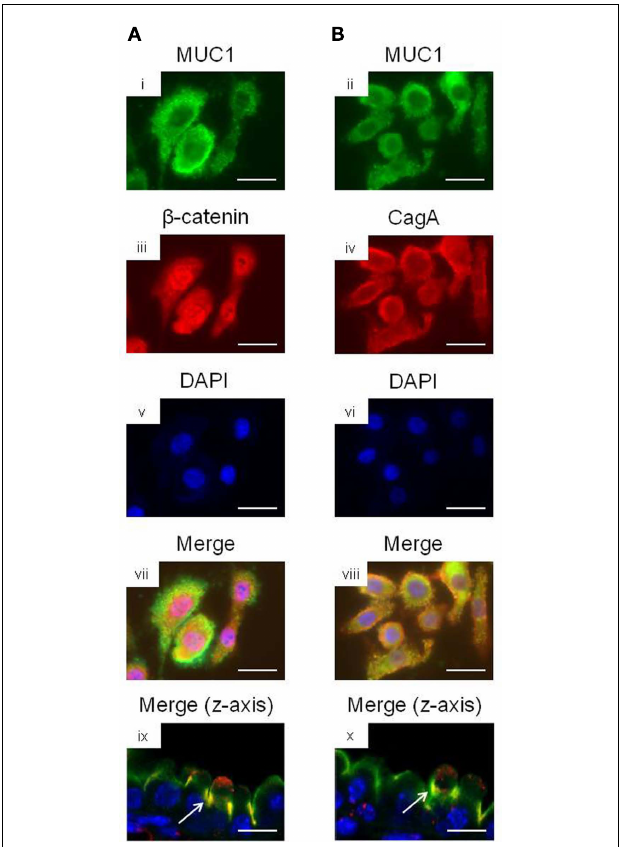
FIGURE 3 | Co-localization microscopy of MUC1, β -catenin, and H. pylori CagA. AGS cells were treated with H. pylori and stained with (A) MUC1 (i) and β -catenin (ii) antibodies, or with (B) MUC1 (iii) and CagA (iv) antibodies.The cells were counterstained with DAPI (v,vi) and examined by immunofluorescence microscopy. Co-localization of MUC1 with β -catenin (vii) , and MUC1 with CagA (viii) , was revealed by yellow immunostaining of merged images. Co-localization of MUC1 with β -catenin (ix) , and MUC1 with CagA (x) was also revealed by confocal microscopy along the z -axis of the cell monolayers, with the apical region of the cells facing up. Arrows in (ix,x) indicate areas of co-localization. Scale bar, 25 μ m.The results are representative of two